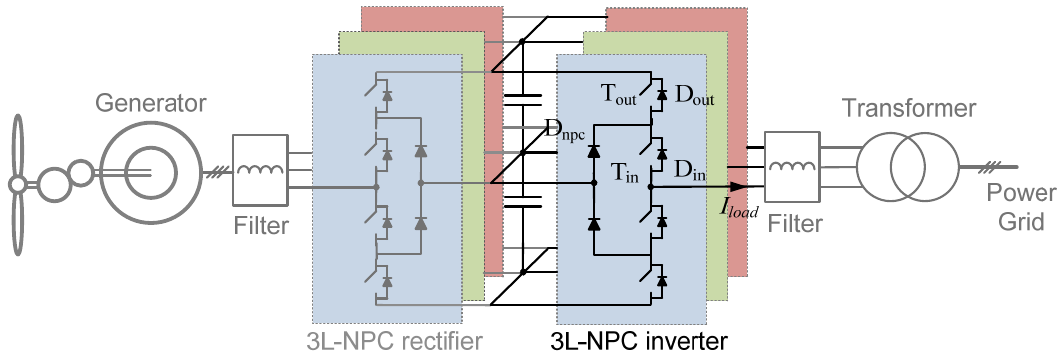
Figure 2. A back-to-back three level neutral-point-clamped wind power converter system.